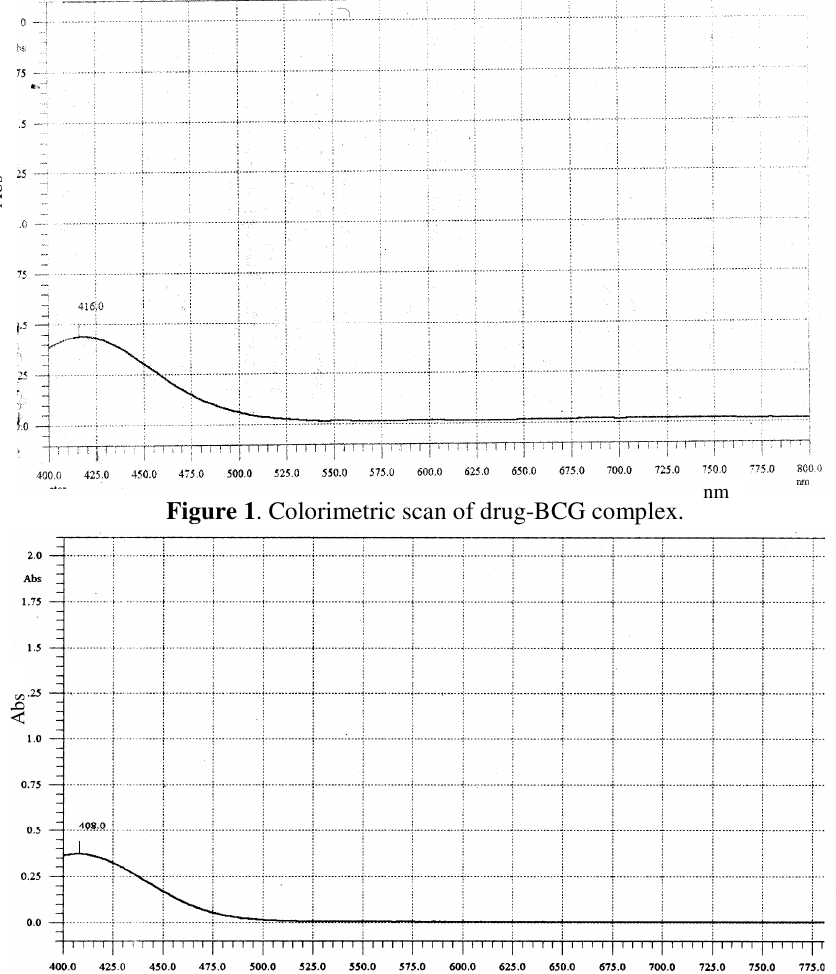
Figure 2 . Colorimetric scan of drug-BCP complex.